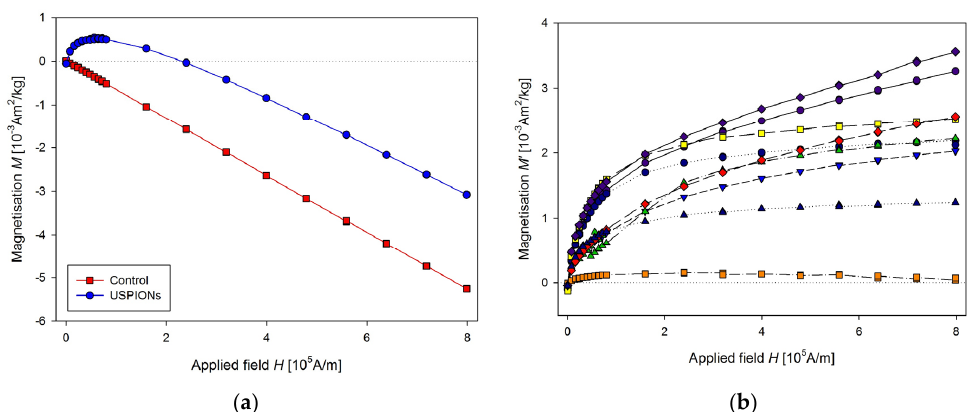
sample. where c is the USPIONs content in the sample (in µg of Fe per gram of the sample dry weight), m Fe is the mass of iron in USPION dispersion (in our case: m Fe = 10 µg) and m sample is the mass of the dried sample.